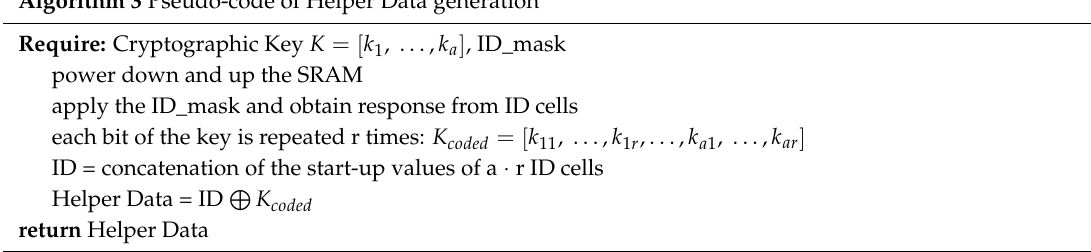
Algorithm 3 Pseudo-code of Helper Data